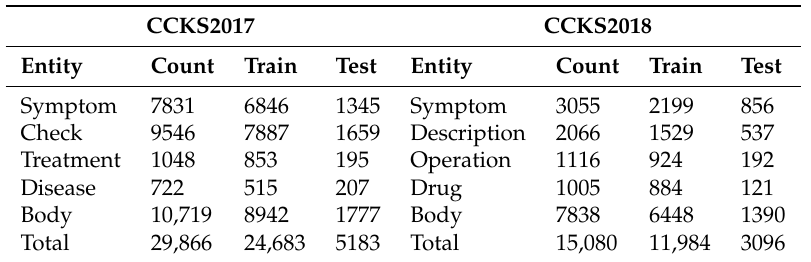
Table 1. Statistics on different categories of entities in the dataset. CCKS, China Conference on Knowledge Graph and Semantic